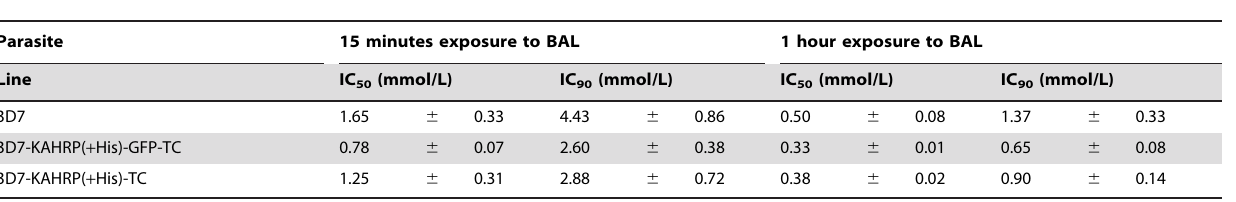
Values are shown as mean of 3 experiments in duplicate with standard errors. Parasites lines 3D7, 3D7-KAHRP ( + His)-GFP-TC and 3D7-KAHRP ( + His)-TC were exposed for 15 min, and 1 h to different concentrations of BAL (0 mmol/L–5 mmol/L).